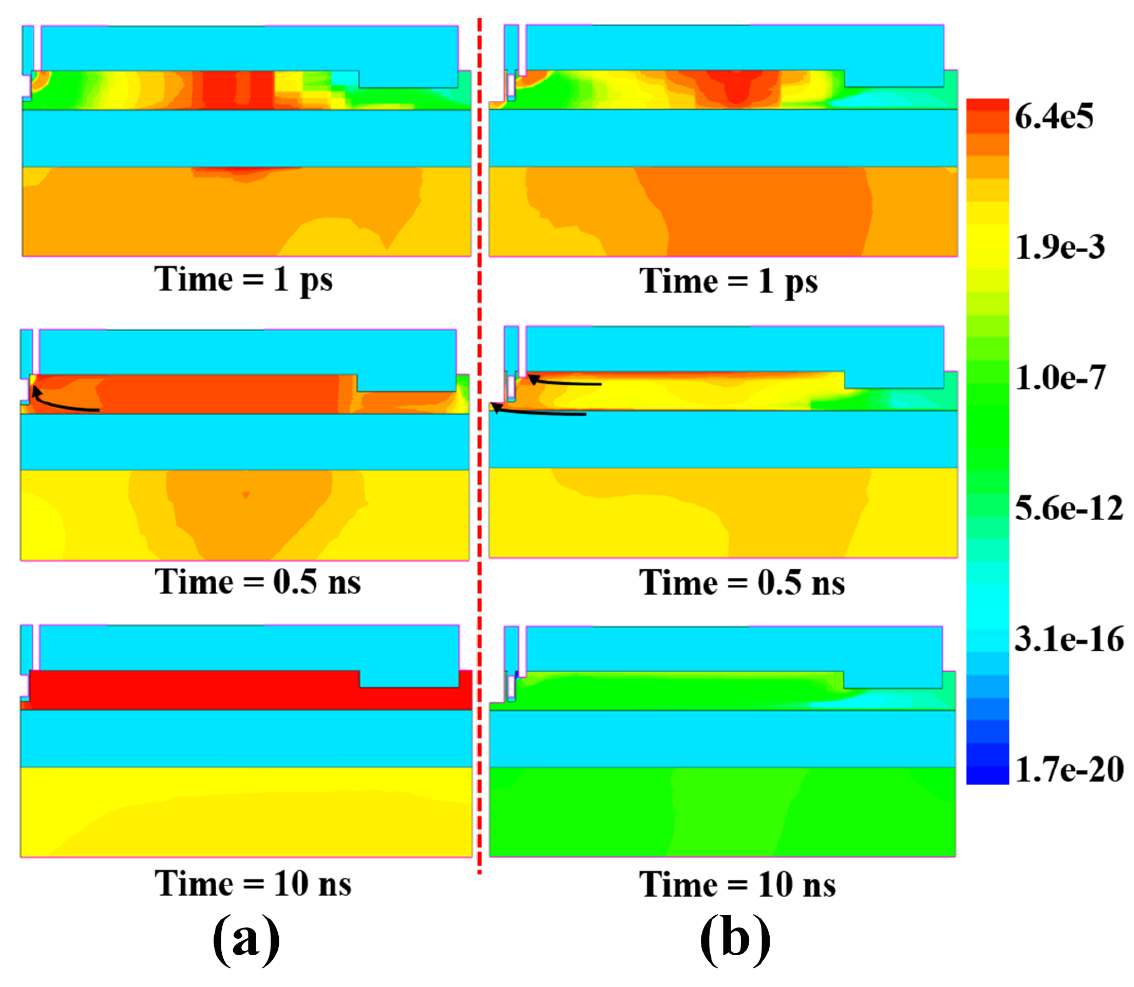
Figure 8. The distribution variations of hole current density with time in ( a ) the CT SOI LDMOS and ( b ) the SJT SOI LDMOS after heavy ions with LET of 1 pC/ µ m strike at Position E when V DS is set as 58 V.